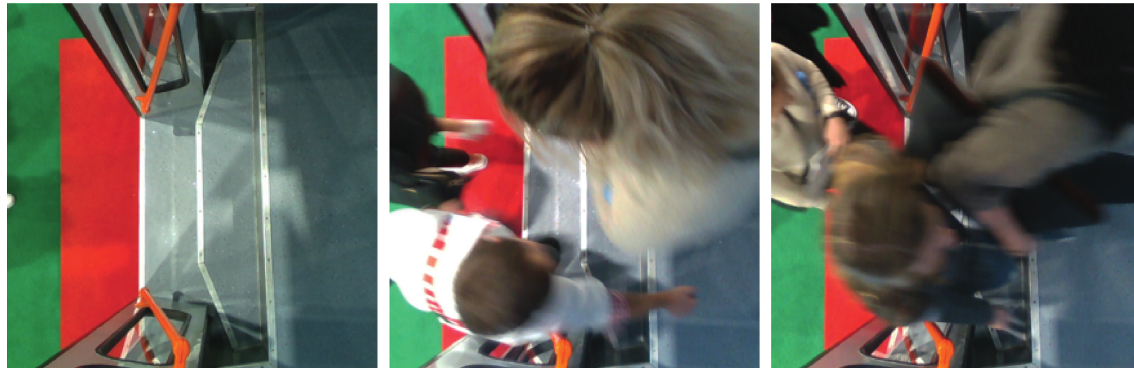
Figure 1: Examples of images orthogonally captured in a tram. Identification of persons in the images according to their faces is implausible.